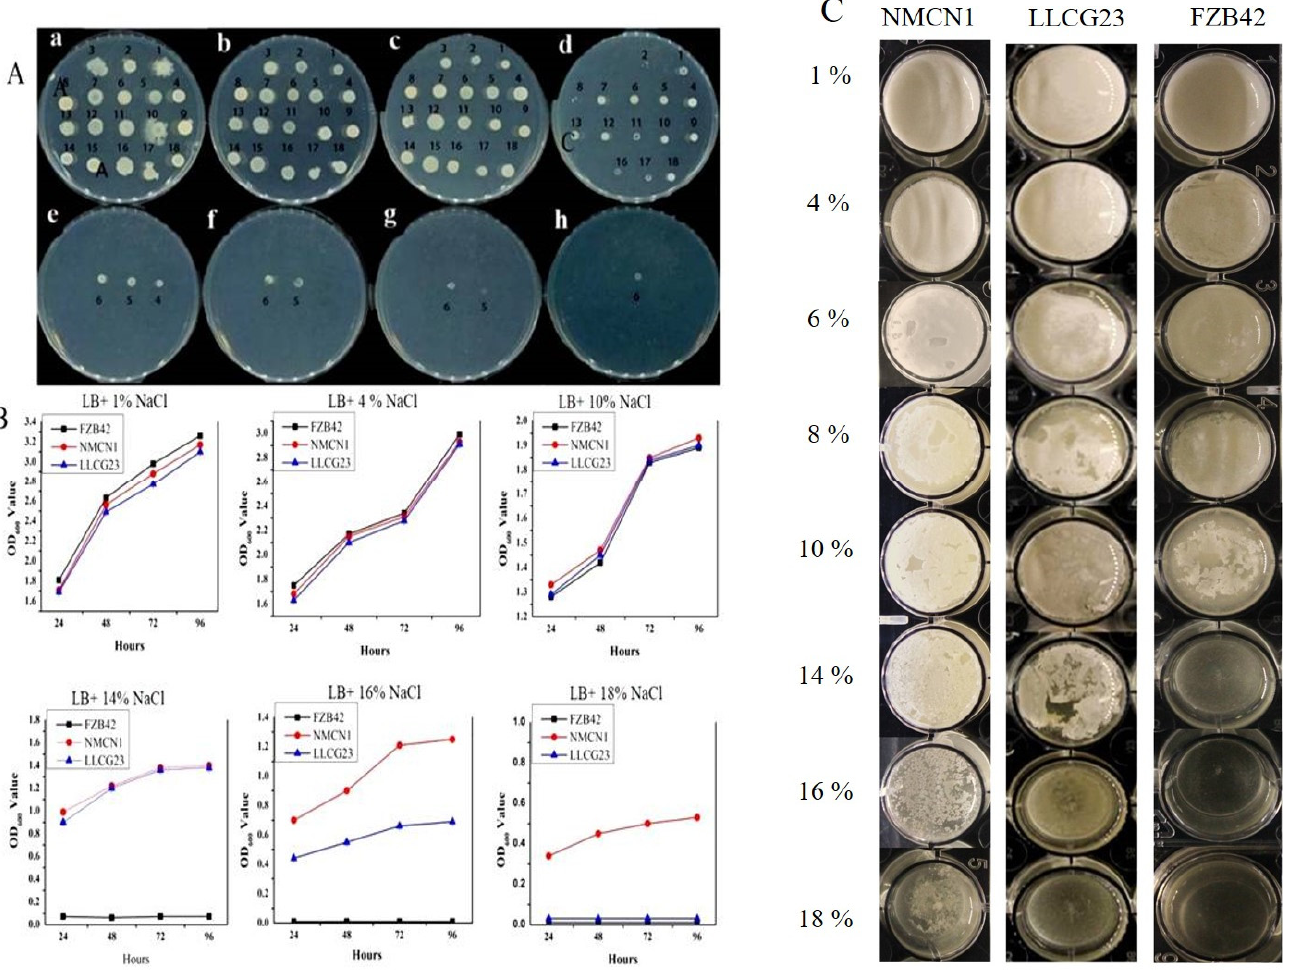
Figure 1. Bacillus spp. strains’ growth and biofilm formation under different saline conditions. ( A ) The visual representation of strains’ growth on solid LB media (a-h) with different NaCl concentra- tions (1–18%). Each number indicates strain: 1. FZB42, 2. B168, 3. EZ-1509, 4. CJCL2, 5. LLCG23, 6. NMCN1, 7. SYST2, 8. LNXM65, 9. TS1, 10. LSSC3, 11. GBSW11, 12. LNXM37, 13. LLTC93, 14. GBAC46, 15. NMCC4, 16. LNXM10, 17. LLTC96, 18. GBWC18. ( B ) Shows the graphical presentation of optical density at different time intervals calculated at (OD 600 ) of high halotolerant strains (MNCN1 and LLCG23) as compared to FZB42 grown in Liquid LB media with different salt con- centrations. ( C ) The biofilm formation potential of selected strains grown under different NaCl con- centrations (1–18%) for 5 days at 37 °C. The experiment was repeated thrice with similar results. Biofilm formation potential results of Bacillus strains (NMCN1, LLCG23 and FZB42) under different NaCl concentration (1%, 4%, 8%, 10%, 16%, and 18%) at 37 ℃ for 5 days showed that all the strains were able to form the finest biofilm up to at 8% however the potential of FZB42 to form biofilm at 10% was reduced and stopped at high NaCl concen- trations of 14-18%. The NMCN1 was observed as the best strain to form biofilm continu- ously up to on 18% NaCl followed by LLCG23. The weak biofilm was noticed at 18% NaCl for NMCN1 while LLCG23 was unable to grow at the same conditions as shown in Figure 1C. 2.2. Relative Expression Profiling of Predicted Genes through qPCR The signal transduction genes, i.e., DegS and DegU, through which bacteria can per- ceive and respond to abiotic stress were detected in the selected strains. The gene super-